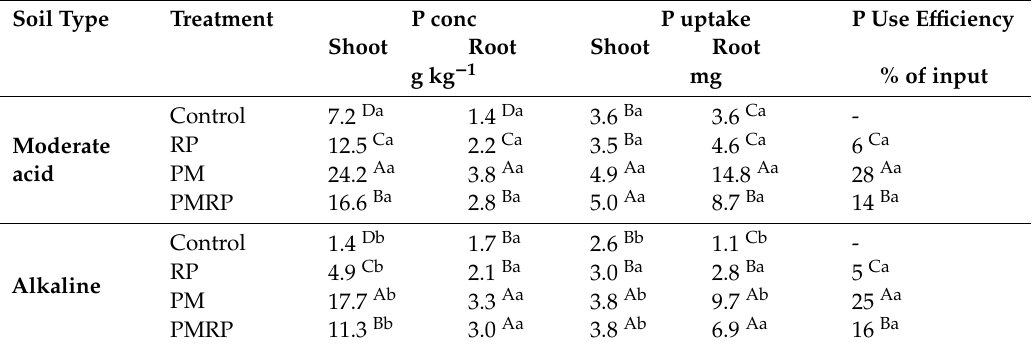
Table 4. P concentration and uptake of roots and shoots and P use e ffi ciency after 7 weeks of ryegrass growth in control soil and soil amended with poultry manure compost (PM), phosphate rock (RP), and their combination (PMRP).